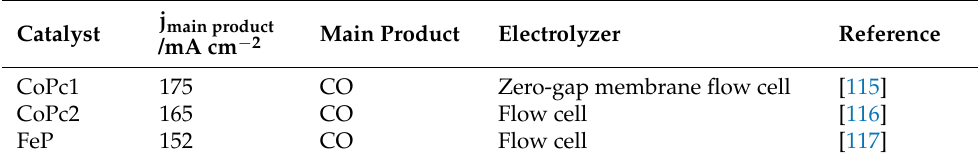
Table 7. CO 2 electroreduction performances of molecular catalysts.